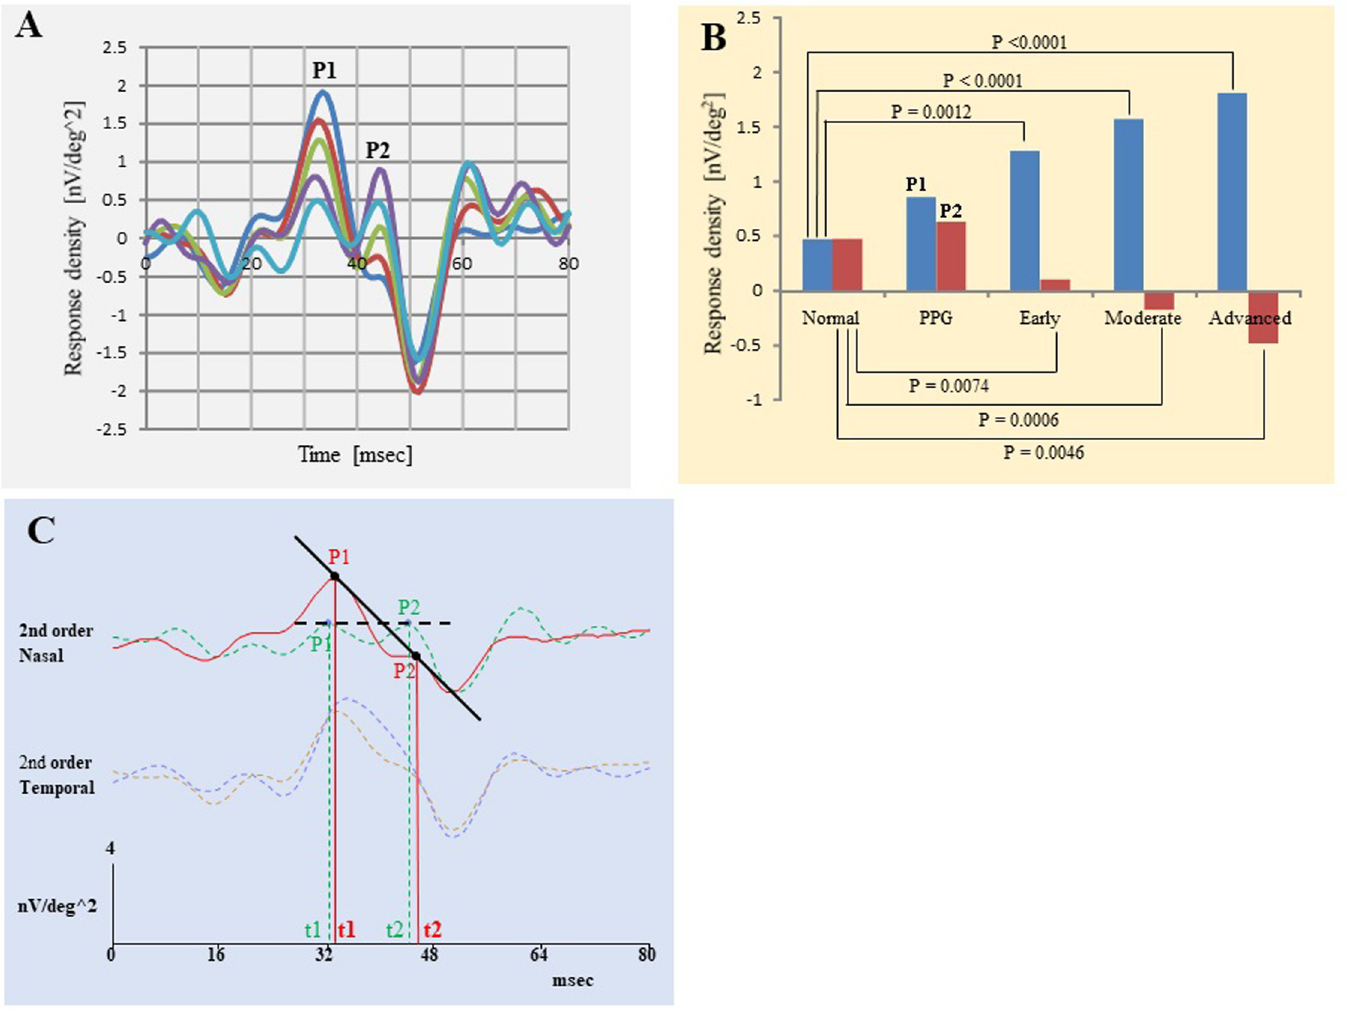
Fig 3. Averaged first slice of second-order kernel of the mfERGs of the nasal hemisphere within the central 7.5˚ for different stages of glaucoma (Blue trace: Advanced stage, Brown trace: Moderate stage, Light green trace: Early stage, Purple trace: PPG stage, and Light blue trace: Normal). A and B: Amplitude of P1 (B: Blue bar) increased, but amplitude of P2 (B: Brown bar) decreased with the progression of glaucoma stage. C: Slope of the line between P1 and P2 (P1P2 Slope) of the nasal response of the second-order kernel (Red line: the nasal response of the second-order kernel of one advanced case. Green broken line is response of one normal subject. The P1P2 Slope on the advanced glaucoma is negatively increased compare with normal